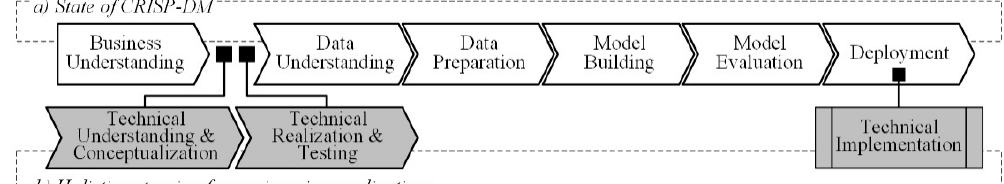
Figure 1. Phases of the reference model of DMME (data mining methodology for engineering applications). ( a ) State of CRISP-DM, ( b ) holistic extension for engineering application.